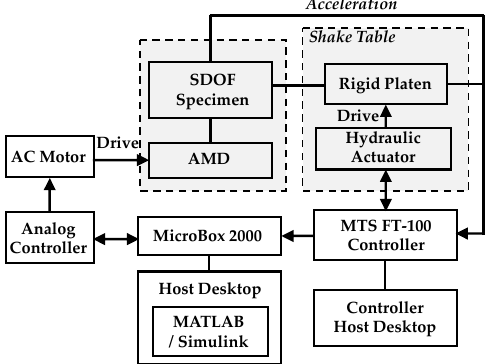
Figure 12. Hardware and software layout for the validating tests.